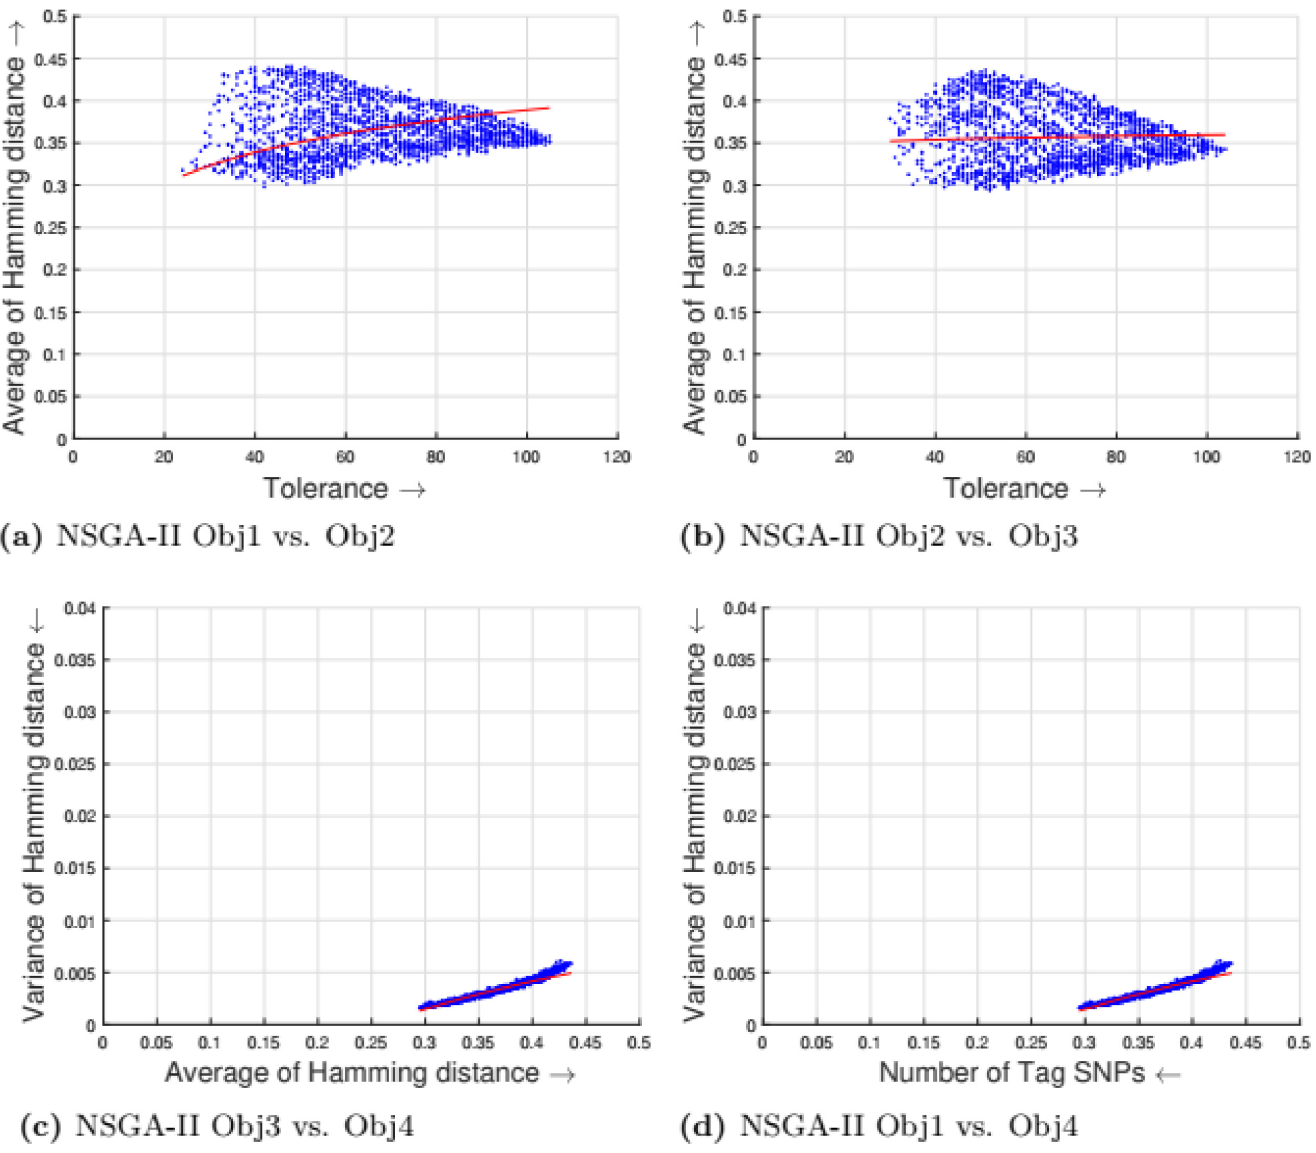
Fig 1. Experimental results of NSGA-II for the tag SNPs selection using random initialization. Obj1 stands for the number of tag SNPs, Obj2 is the tolerance for missing data, Obj3 measures the average Hamming distance between alleles, and Obj4 controls the variance of detection power in each allele. (a) NSGA-II obj1 vs. Obj2, (b) NSGA-II Obj2 vs. Obj3, (c) NSGA-ll Obja vs. obj4, (d) NSCA-II Ohj1 vs. Obj4.